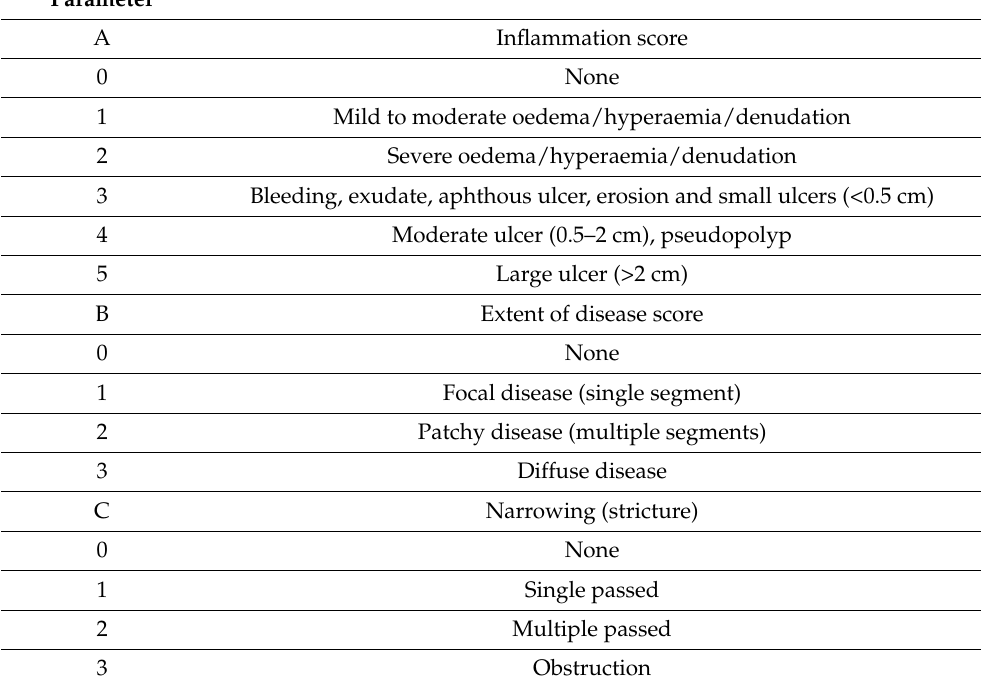
Table 4. CECDAIic score 1